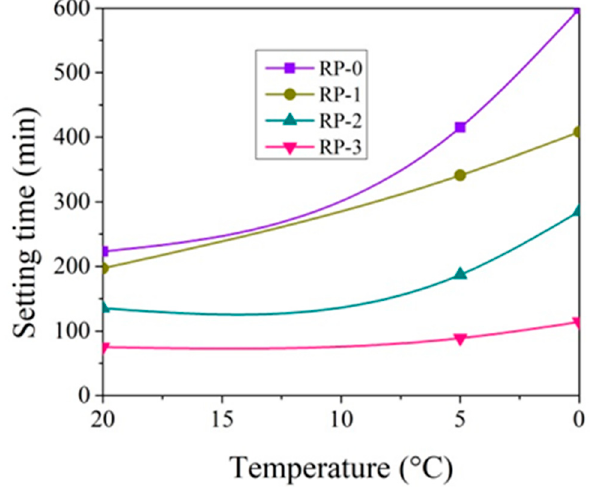
Figure 5. Final setting times of CEM IIR paste with 0–3% CN at different temperatures.